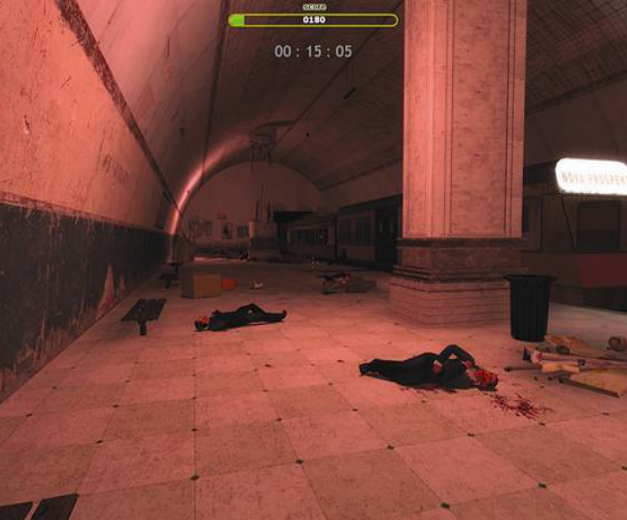
Figure 1 . Subway platform in the game Code Red